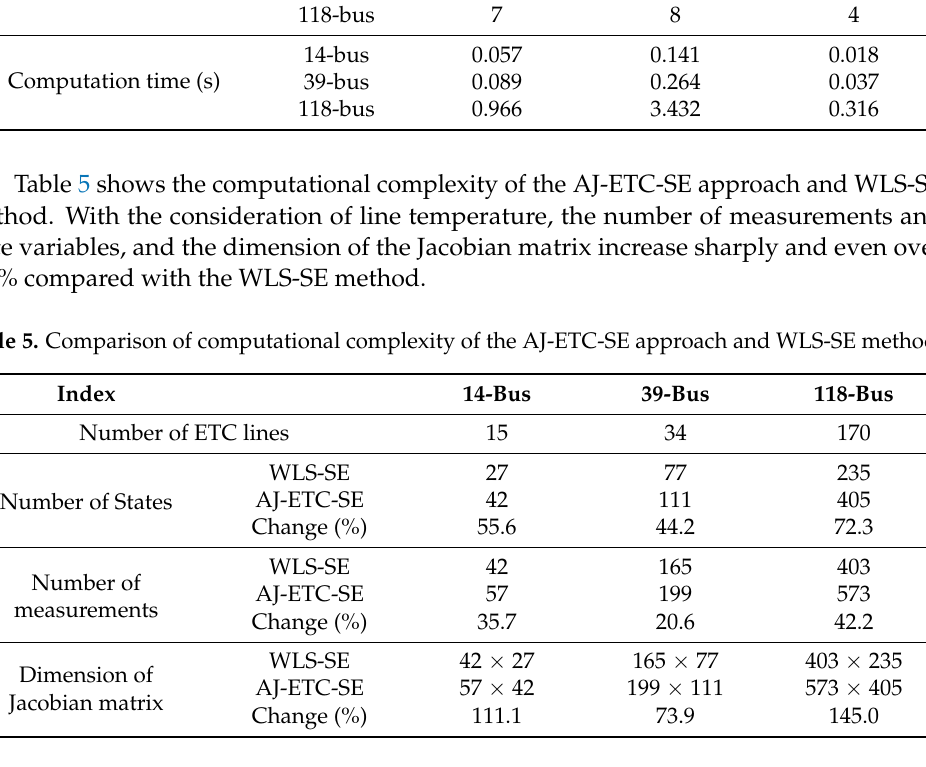
Table 4. Comparison of iteration numbers and computation time.